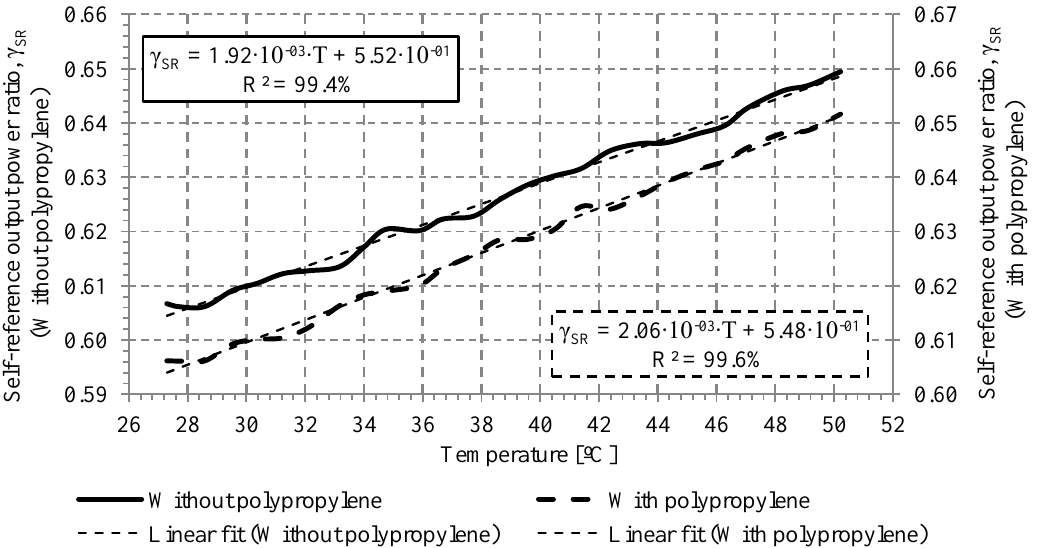
Figure 8. Calibration curves for a sensor with and without tape coating.